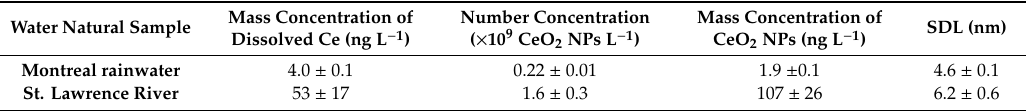
analysis of triplicate